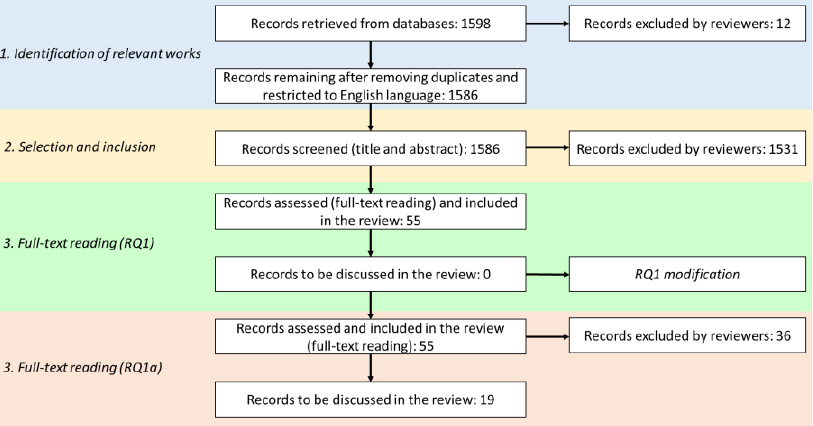
Figure 1. Overview of the literature review steps.